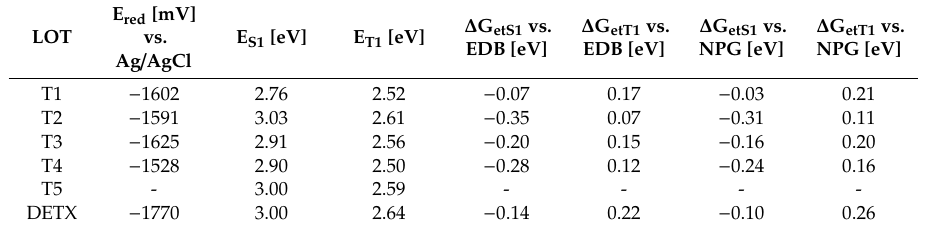
Table 8. Electrochemical and thermodynamic properties of sensitizers and their interaction with amines EDB and NPG.